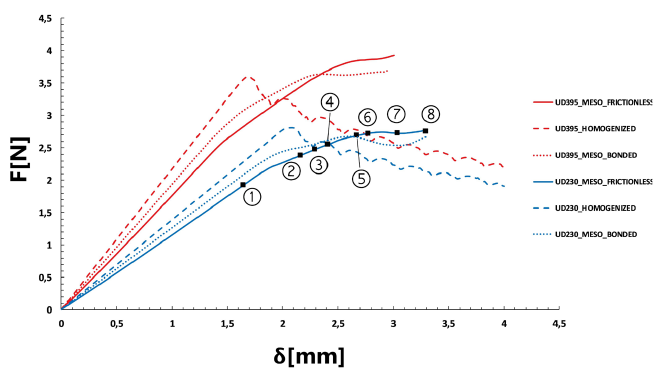
Figure 8. Force vs. displacement in the DCB numerical test. δ stands for the displacement of the edge with the BC1 and F denotes the measured reaction force (Point 1 refers to the moment prior to the beginning of the propagation).